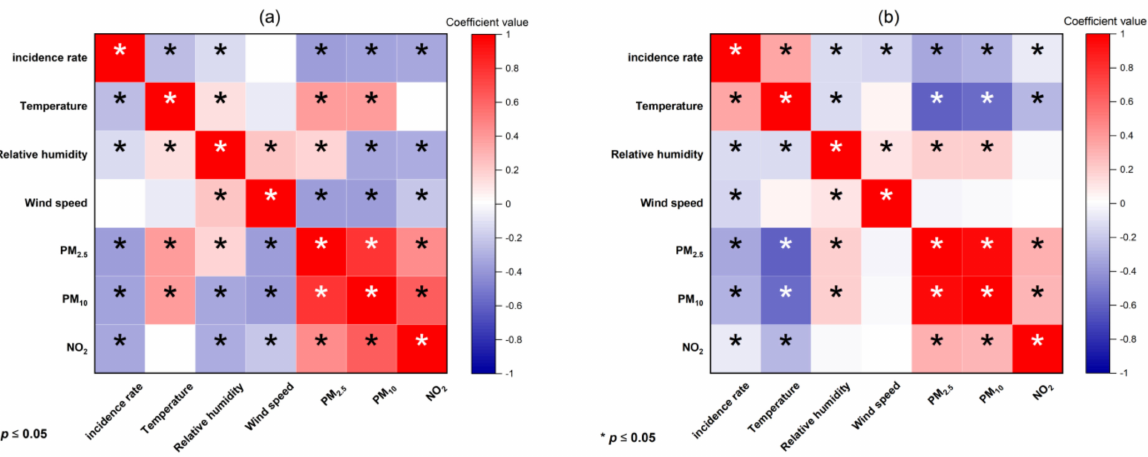
Figure 8. Results of Spearman correlation analysis (* stands for a higher and more significant correlation ( p -value < 0.05)) in northern cities ( a ) and southern cities ( b